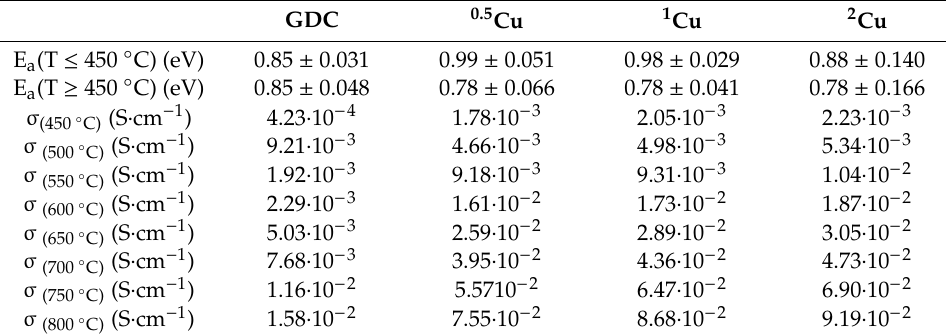
Table 4. Total conductivities and activation energies.